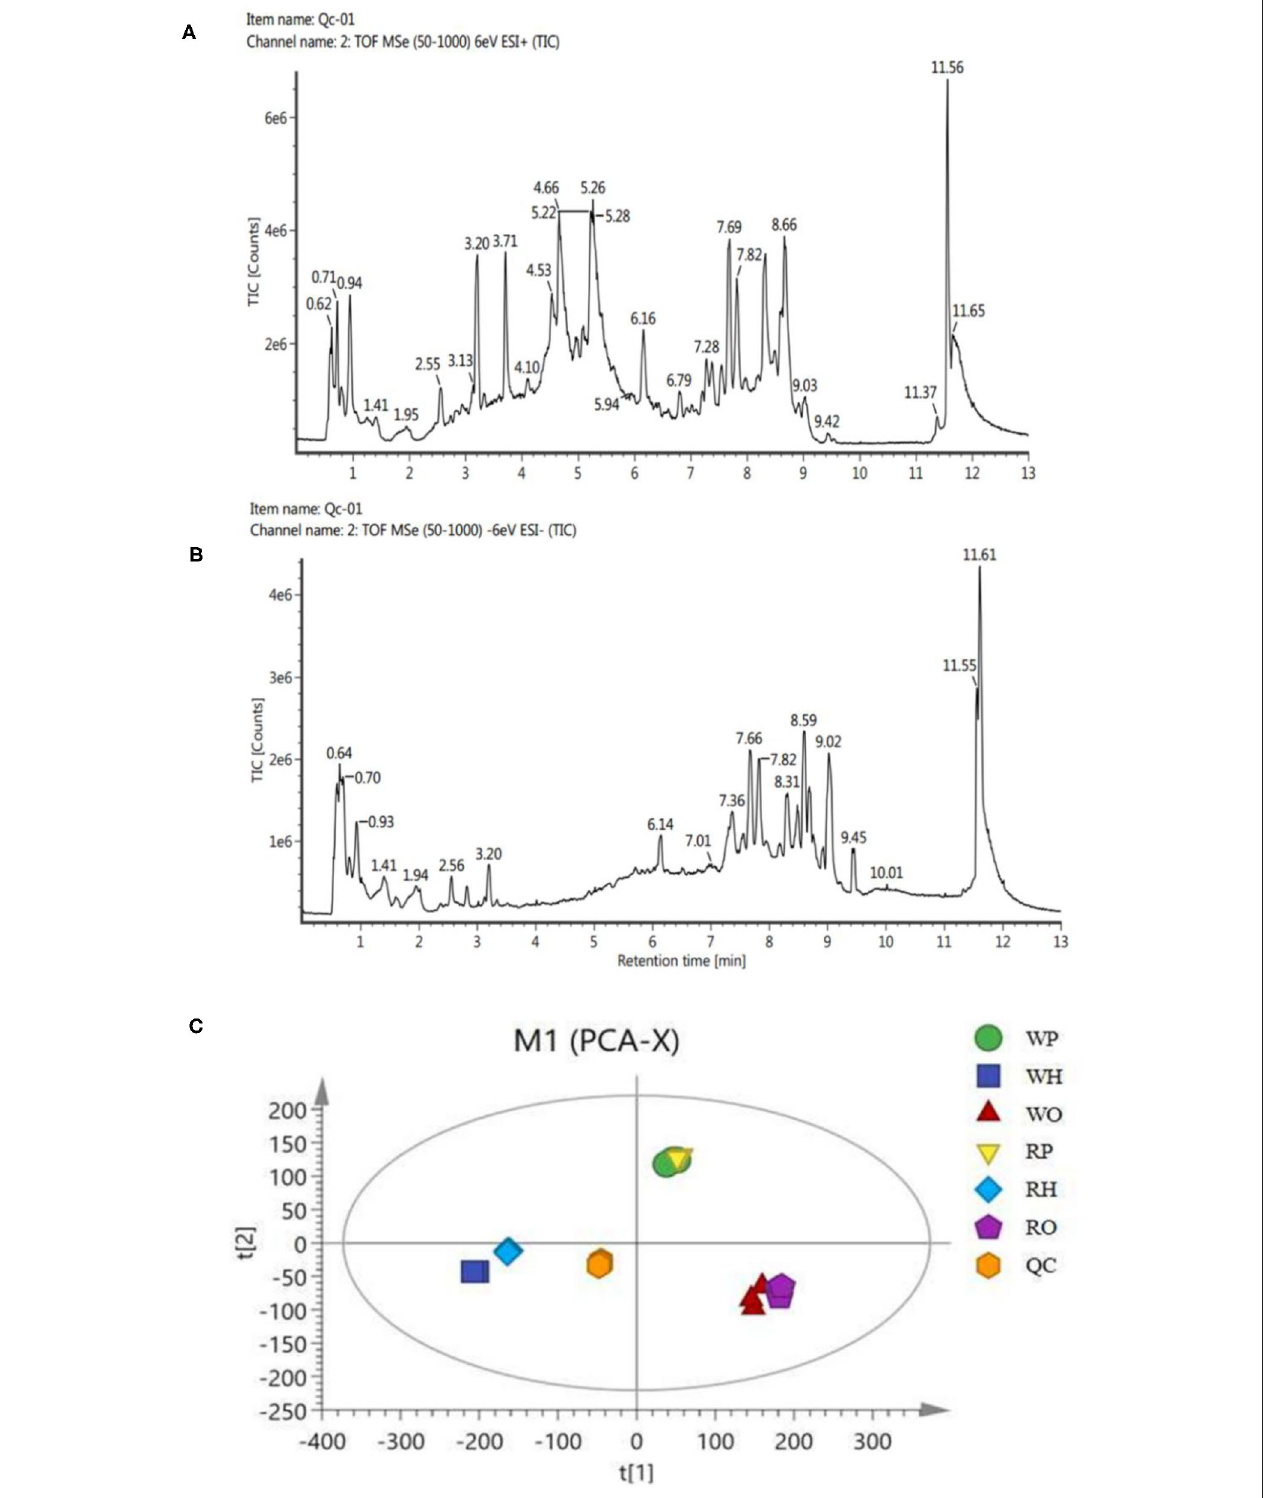
FIGURE 1 | (A) BPI( + ) ion flow chart of control samples. (B) BPI(-) ion flow chart of control samples. (C) PCA plots for all samples.